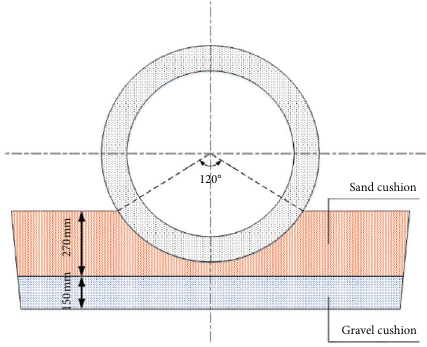
Figure 2: Simulation of pipeline cushion.